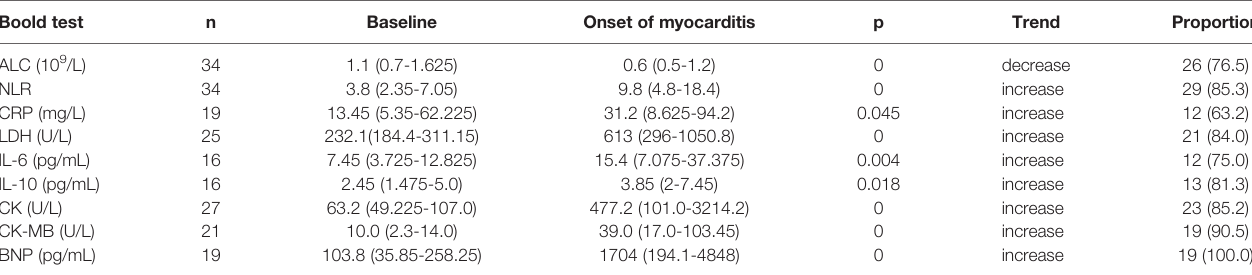
TABLE 2 | Changes in labortory tests.